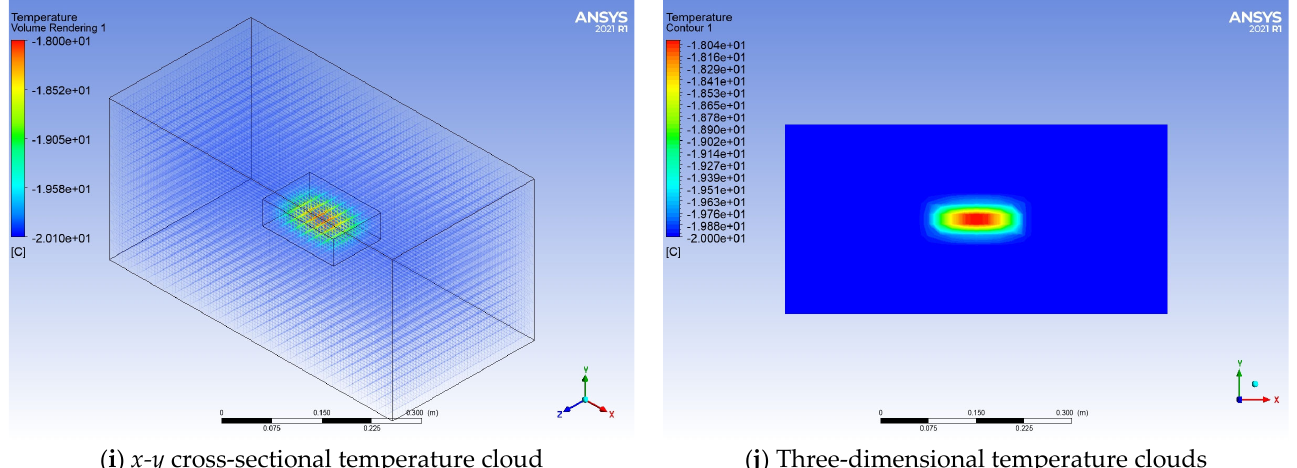
Figure 5. Temperature field program and x ‐ y section temperature program under different flow rates of refrigerant.